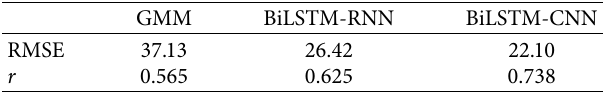
Table 2: The RMSE (Hz) and r on the test set when using GMM, BiLSTM-RNN, and BiLSTM-CNN for EMA-to-F2